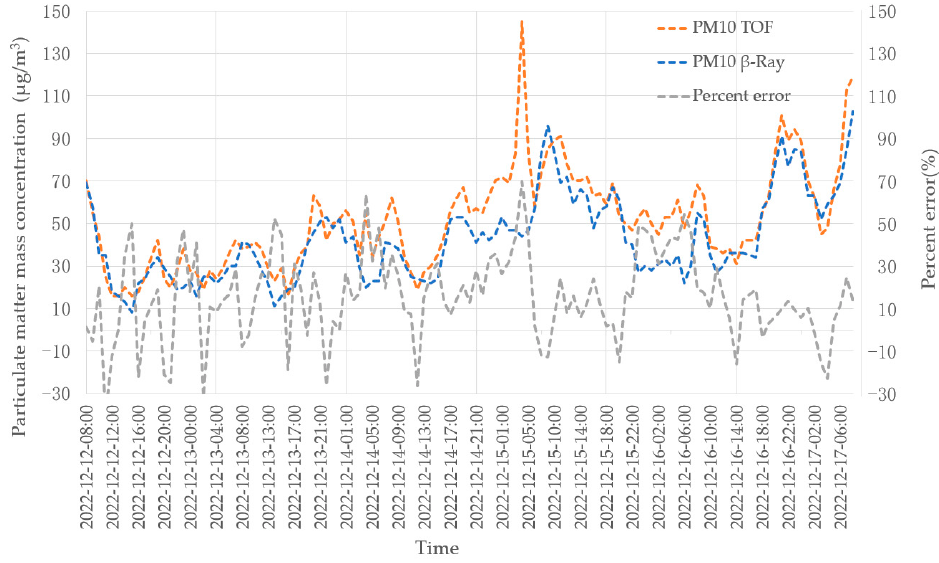
Figure 13. Actual measured concentration of PM10.